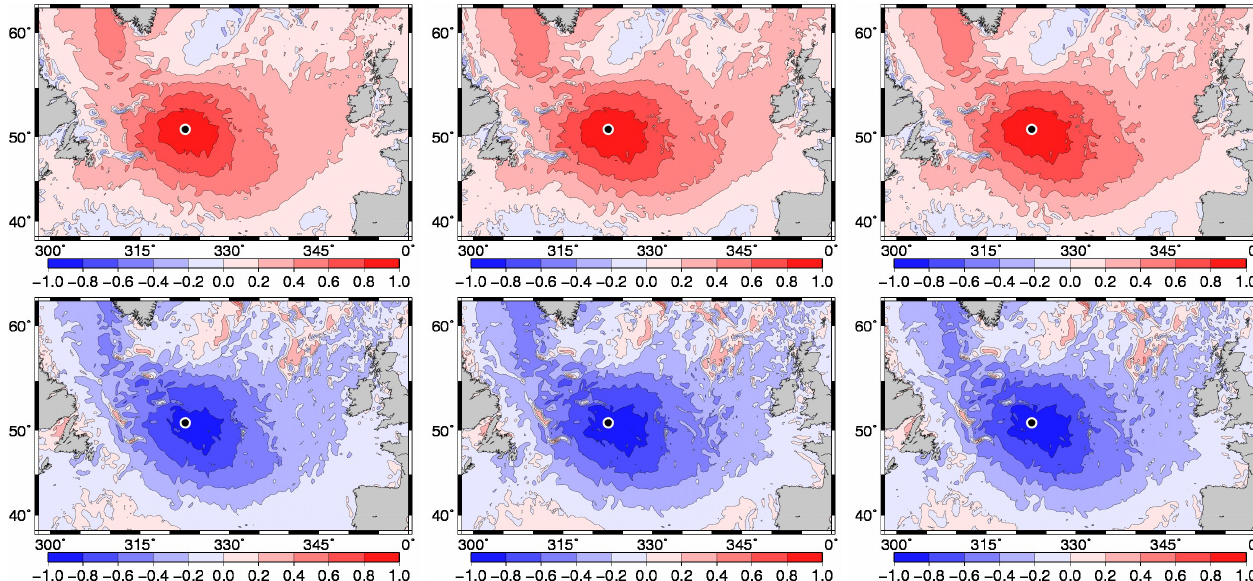
Fig. 7. Phytoplankton (top panels) and nitrate (bottom panels) horizontal correlation structure with respect to phytoplankton at 37.5 ◦ W 50.8 ◦ N (North Atlantic), as obtained for the original variables (left panels), their local rank in the ensemble (middle panels), and the transformed variables after Gaussian anamophosis (right